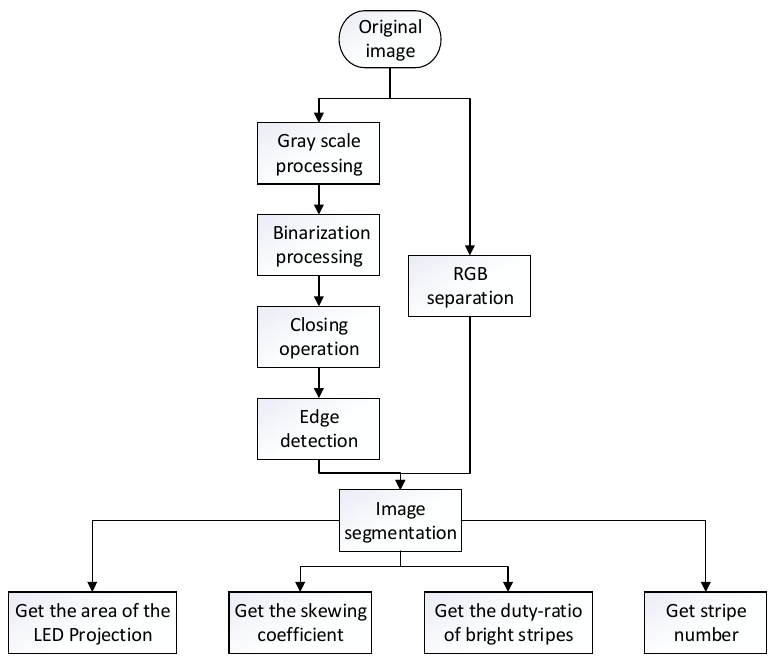
Figure 8. Processing of LED features extraction.